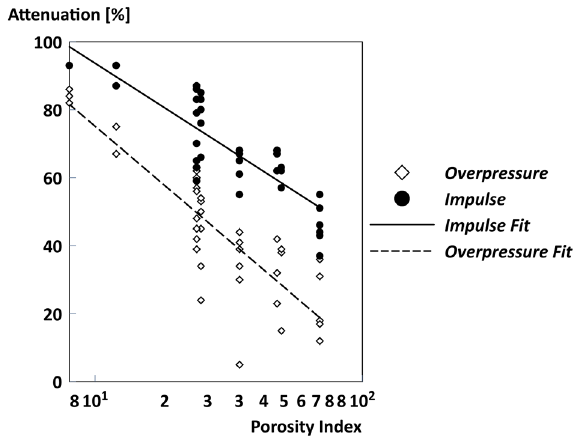
Fig. 14 Attenuation of the overpressure and of the impulse as a function of the porosity index (P/N) in a logarithmic scale. Over- pressure fit: 141-29 ln(P/N); impulse fit: 141-21